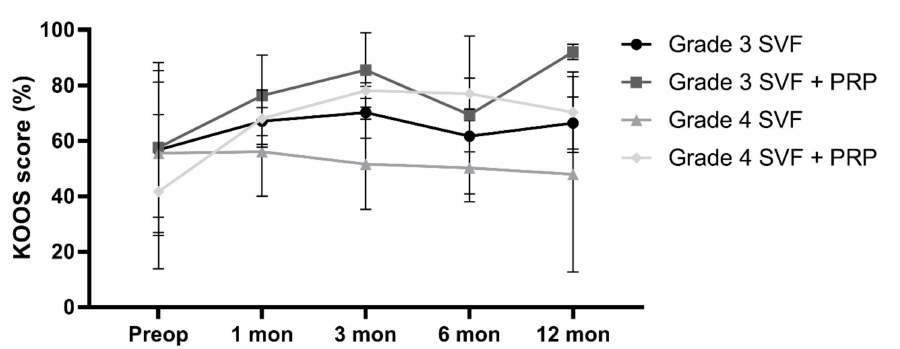
Figure 5. Progression of the KOOS scores of the four treatment groups at baseline as well as 1, 3, 6, and 12 months after the treatment of knee osteoarthritis with freshly isolated SVF from the adipose tissue; n = 3 for each group at each time point; KOOS, Knee injury and Osteoarthritis Outcome Score. PRP, platelet-rich